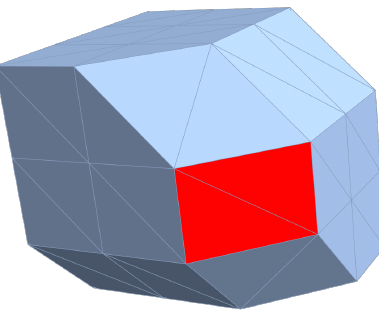
Figure 13. A degenerate cluster polytope of A 2 , 1 corresponding to the tropicalization of polyno- mials in eq. (4.8). The red facet corresponds to the limiting ray.